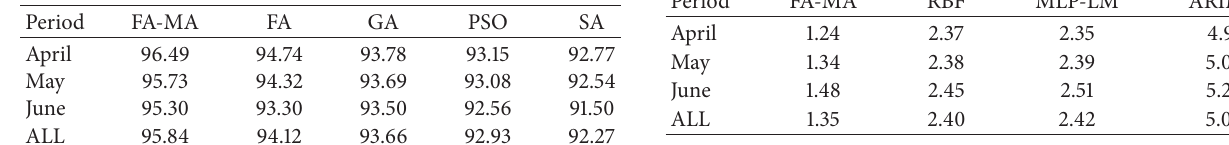
Table 5: DS (%) of SVR model with different parameter determina- tion methods.